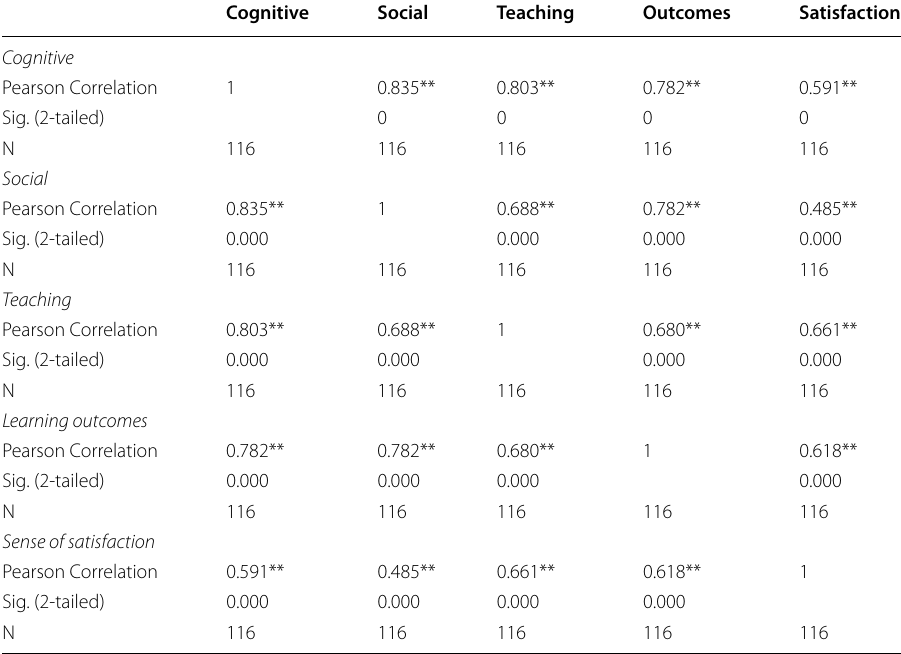
**Correlation is significant at the 0.01 level (2-tailed)